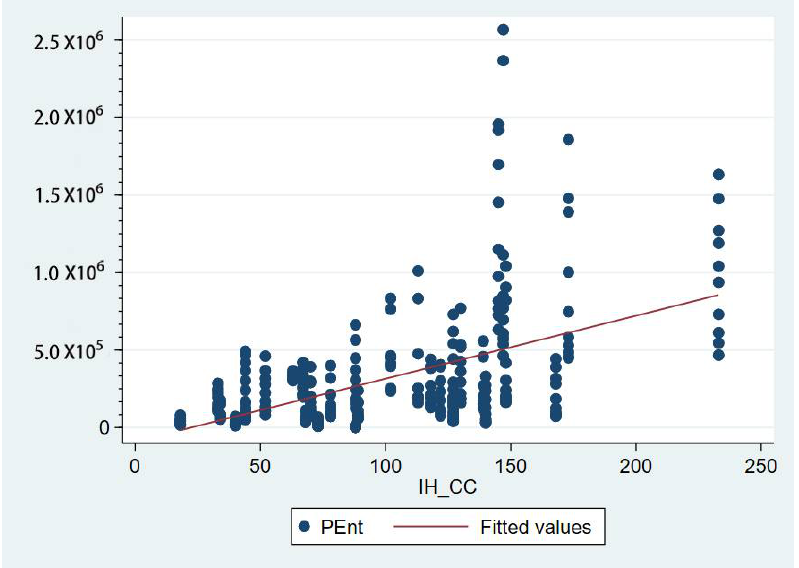
Figure 1. Relationship between intangible cultural heritages and entrepreneurship. Source: China Statistical Yearbooks, China Economic Census Yearbook and the website of Chinese Intangible Cultural Heritage.